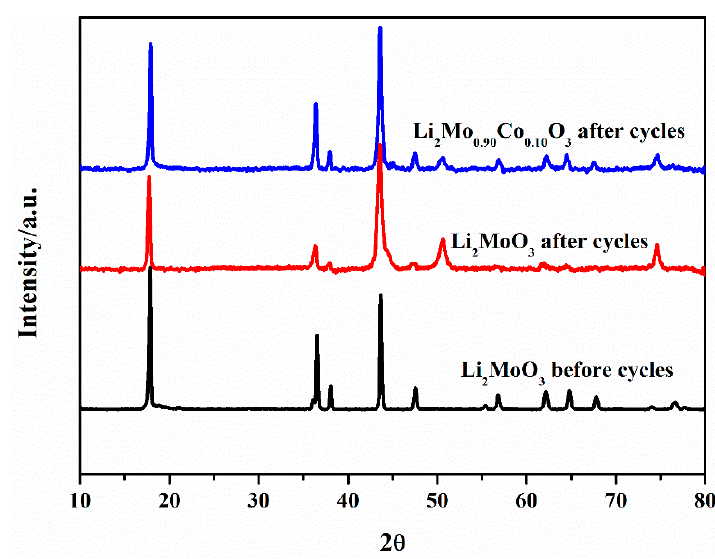
Figure 11. XRD patterns of Li 2 MoO 3 and Li 2 Mo 0.90 Co 0.10 O 3 after 20 cycles.